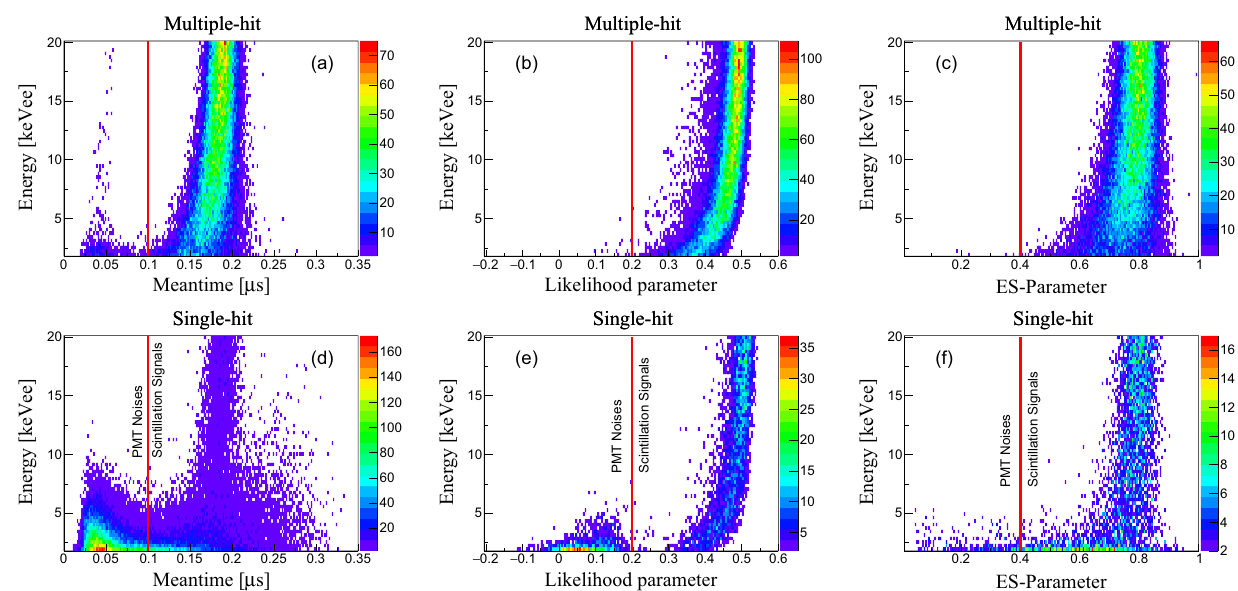
Fig. 14 Distribution of the event selection parameters: mean time (left a and d ), likelihood parameter (middle b and e ), and ES parameter (right c and f ), are presented separately for the multiple-hit (top a – c ) and single-hit data (bottom d – f ). As the multiple-hit data is less affected